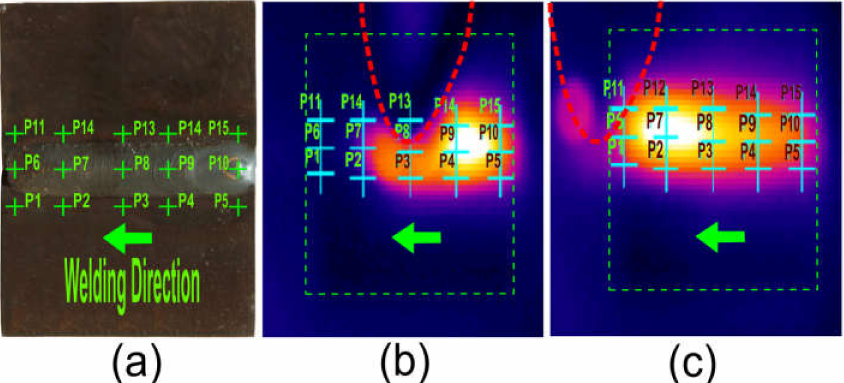
Figure 2. ( a ) Points that were considered for the temperature field measurement of the butt joint with single V-groove welded joint; ( b ) The temperature recorded by the thermographic camera at second 6; and, ( c ) The temperature recorded by the thermographic camera at second